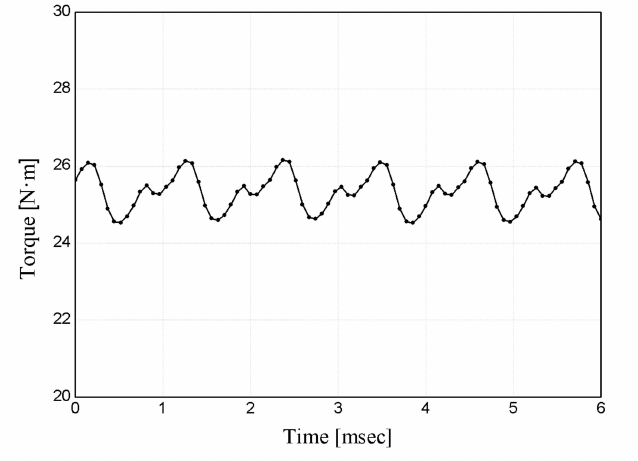
Figure 2. Torque waveform of the initial model.